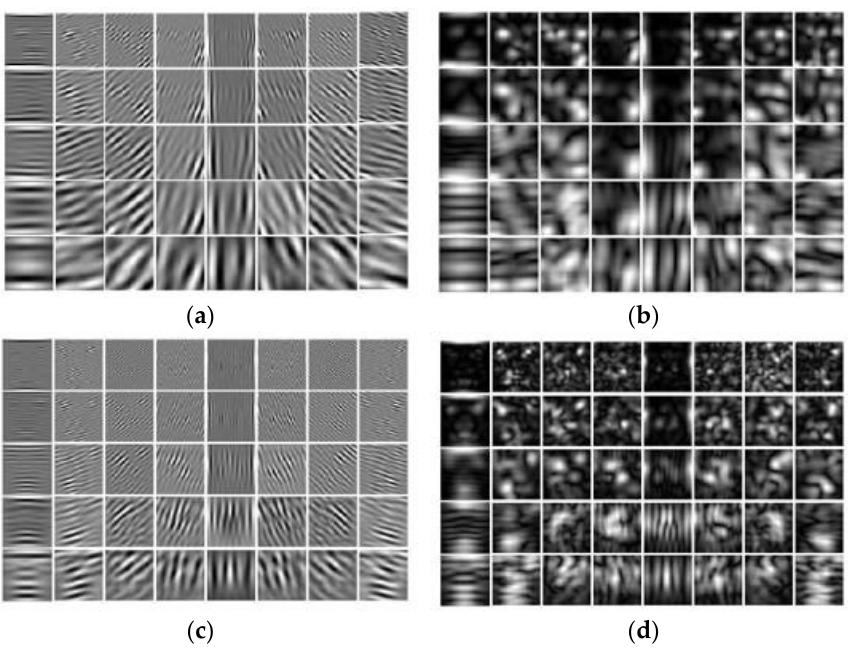
Figure 8. Gabor wavelet image representations: ( a ) OLR database images Gabor representation ( b ) OLR images magnitude representation ( c ) Extended Yale-B database representation and ( d ) magnitude value of Extended Yale-B database.